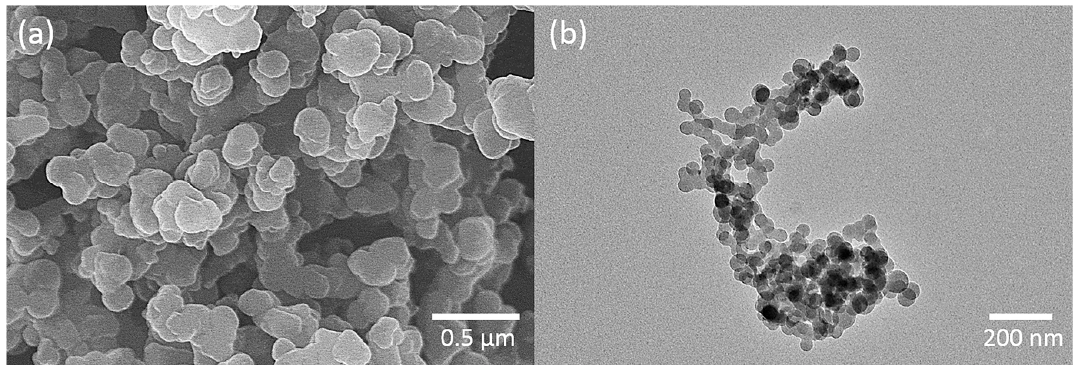
Figure 5. Representative SEM ( a ) and TEM ( b ) images of the BADCy resin nanoparticles.